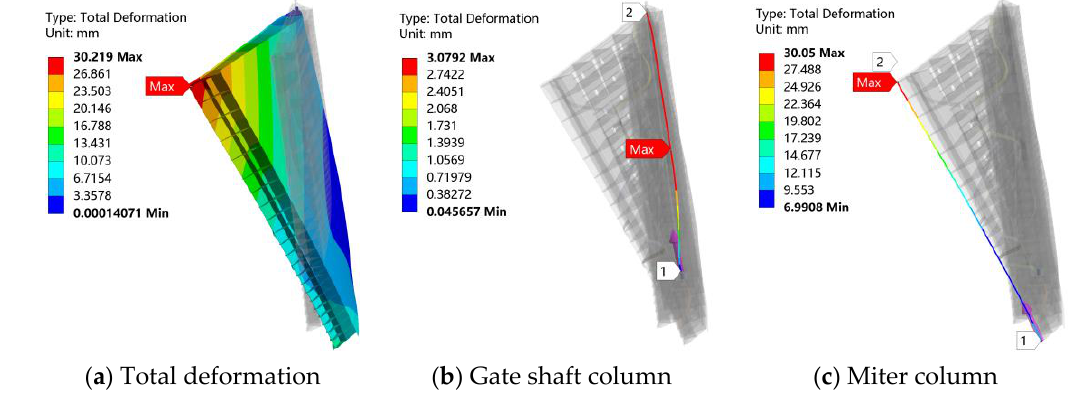
Figure 10. (a) Deformation of the overall gate, ( b ) Deformation of the gate shaft column, and ( c ) Deformation of the miter column with the back tie rod under self-weight. Table 3. The maximum deformation of the gate with or without the back tie rod under no external force and self-weight mm.